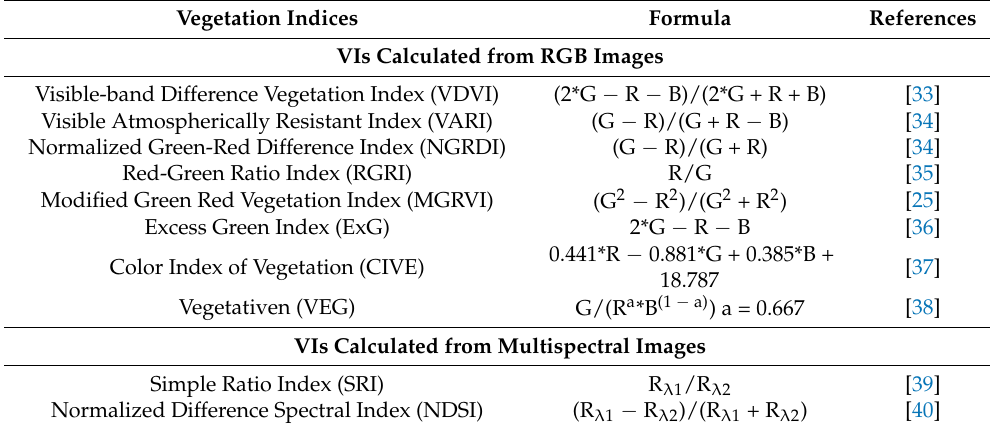
Table 1. Vegetation indices (VIs) derived from RGB and multispectral images in this study (R, G and B are related to the DN value or reflectance of red, green, and blue bands, respectively. R λ 1 represents the reflectance of a variable band in the spectral range of 600–1000 nm).